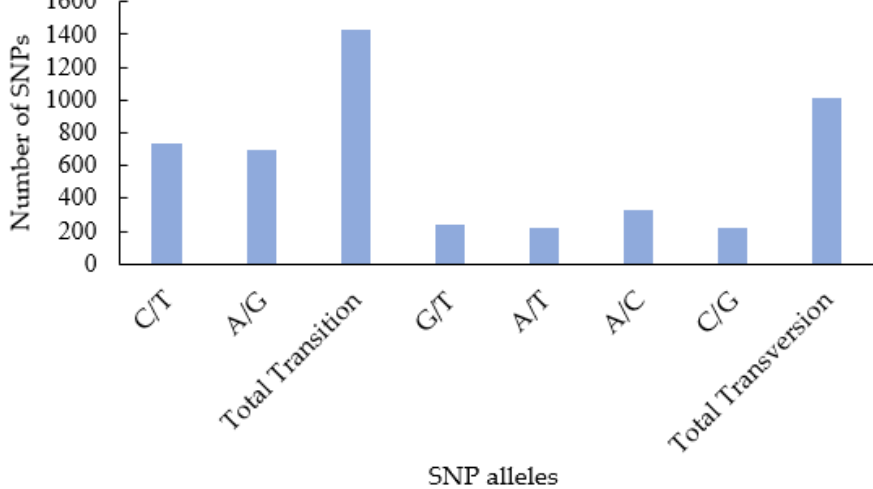
Figure 1. Histogram plot showing SNP distribution and transition/transversion from SNPs identified from de novo ddRAD-sequencing.